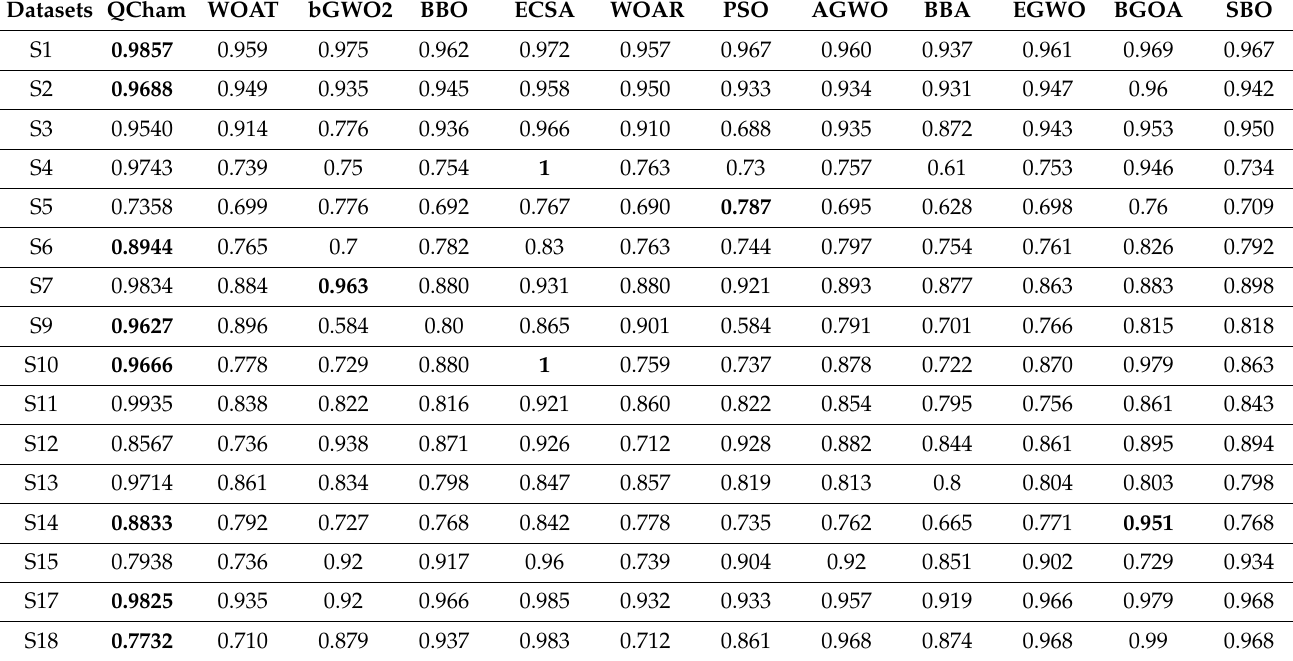
Table 9. Comparison with FS